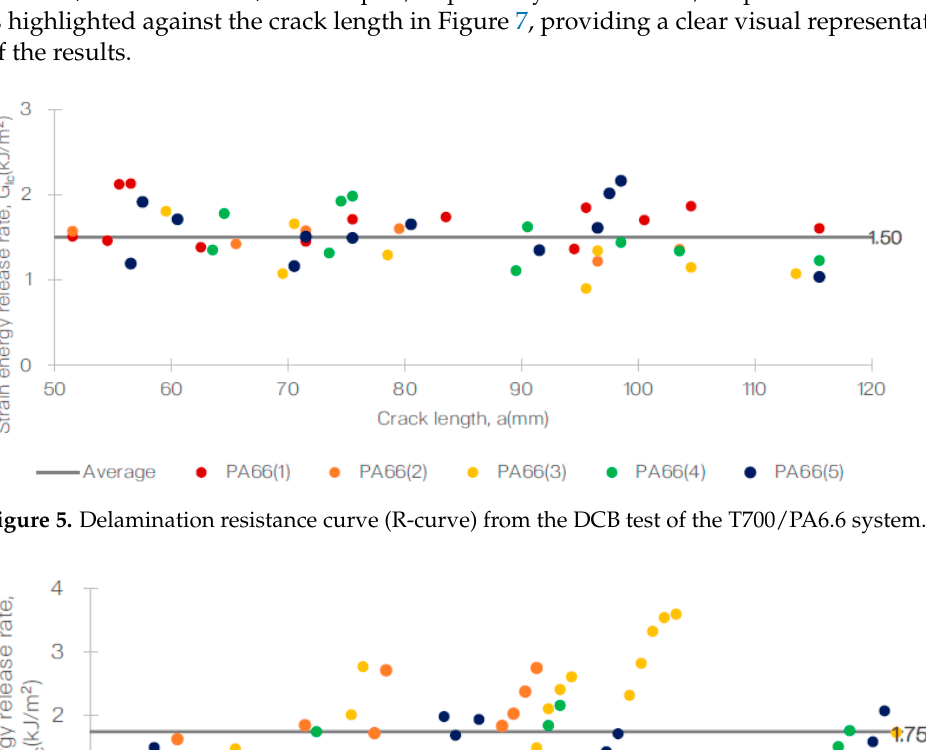
Figure 7. Representative R-curve (specimen #1 T700/PA6.6) against measured crack length. Based on the R-curves obtained for both specimens, the Mode I fracture toughness, 𝐺 (cid:3010)(cid:3030) , for both samples, was calculated and tabulated as shown in Table 3. The average 𝐺 (cid:3010)(cid:3030) calculated for the T700/PA6.6 and T700/PPS were 1.50 kJ/m 2 (CV = 9.7%) and 1.75 kJ/m 2 (CV = 8.6%), respectively. These results demonstrate that the Mode I interlaminar fracture toughness of the T700/PPS is approximately 17% higher than the T700/PA6.6 system. Table 3. Summary of the Mode I interlaminar fracture toughness of T700/PA6.6 and T700/PPS. Study